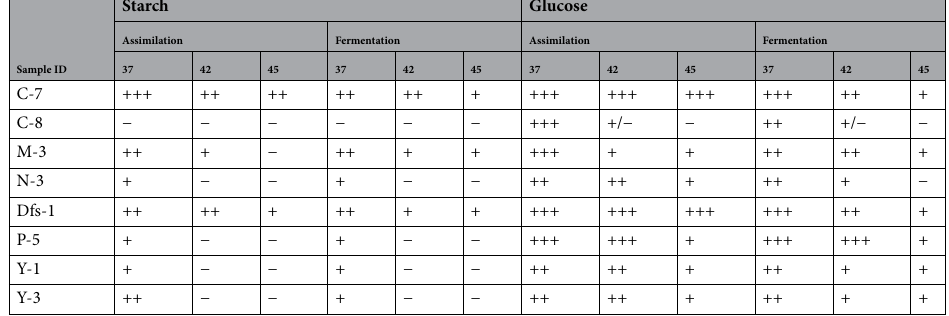
Table 1. The effect of various medium temperatures (°C) and carbon sources on the growth of thermotolerant microbes isolated from the various fermented sources of Bangladesh. Three-isolates (C-7, M-3 and DFS-1) could assimilate and ferment both starch and glucose at 42 °C where C-7 showed maximum result. Remaining 5-isolates (C8, N3, P-5, Y1 and Y3) showed very weak or no starch assimilation as well as fermentation at 37, 42 and 45